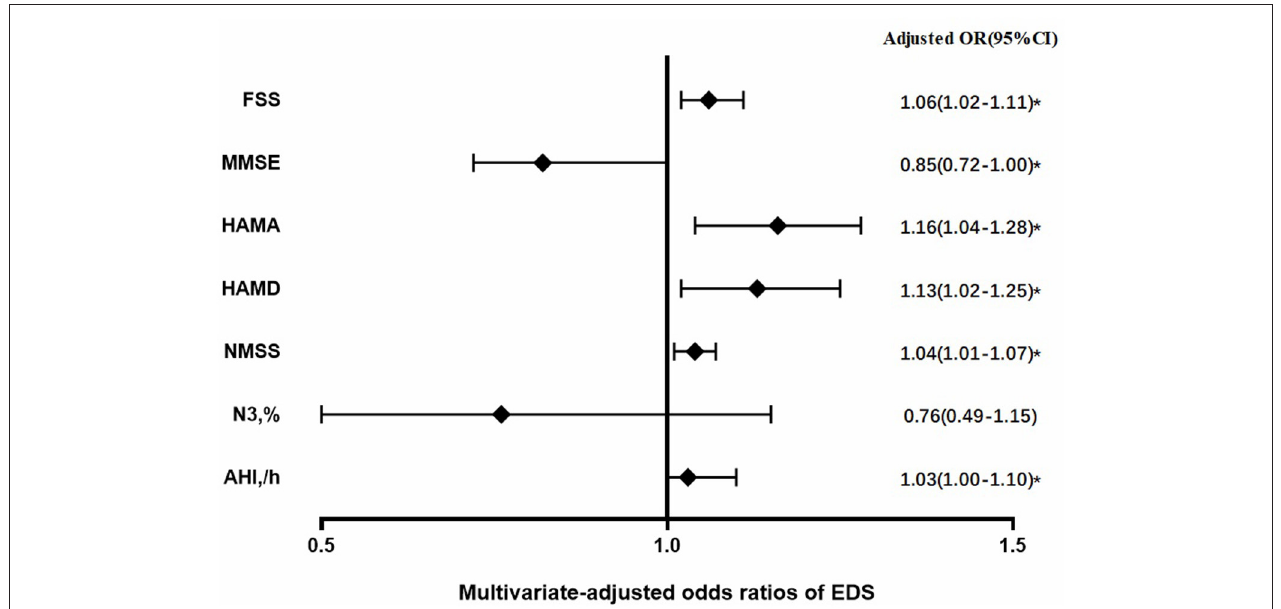
FIGURE 1 | Risk factors of excessive daytime sleepiness (EDS) in patients with multiple system atrophy (MSA) after adjustment for age, sex, disease duration, MSA sub-type, and UMSARS score; OR, odds ratio; CI, confidence interval; * P <